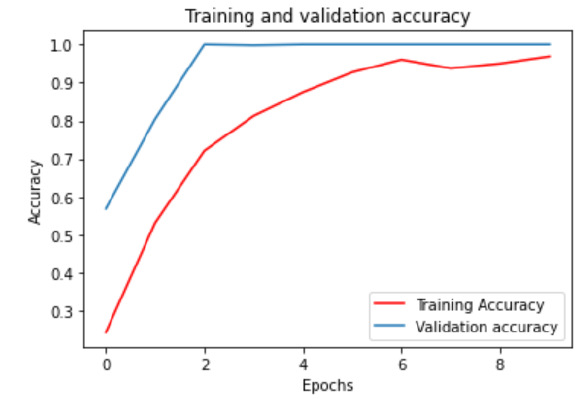
Figure 4. Outputs from the first hidden